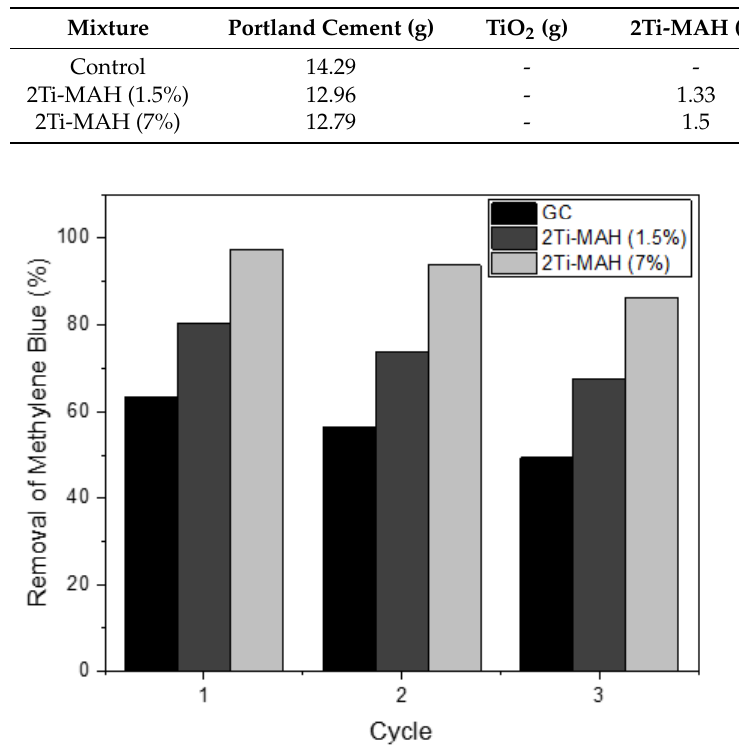
Figure 13. Absorbance over cycles comparison of 2T-iMAH (7%) and 2Ti-MAH (5%).